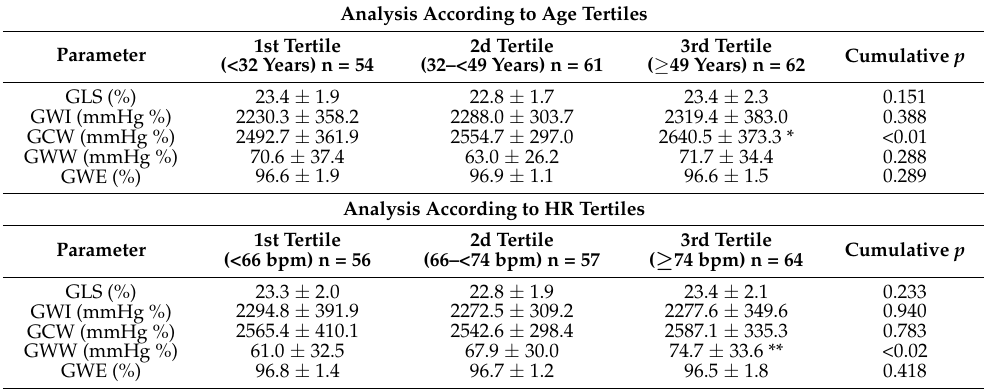
Table 2. Myocardial work components according to age tertiles. Analysis According to Age Tertiles Parameter